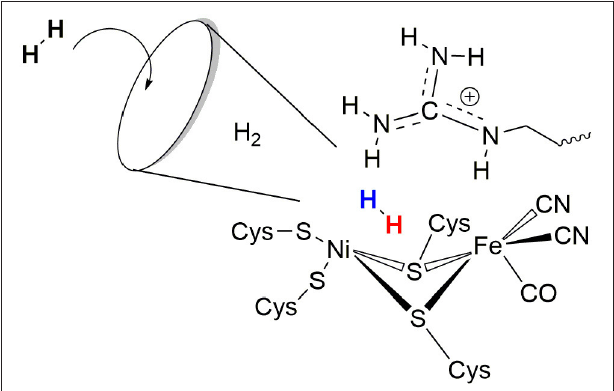
A positive energy indicates the singlet state of Ni(II) to be the ground state. RC: reactant complex (H 2 @Ni-SIa complex). PC76: protonated cysteine C76. PC576: protonated cysteine C576.